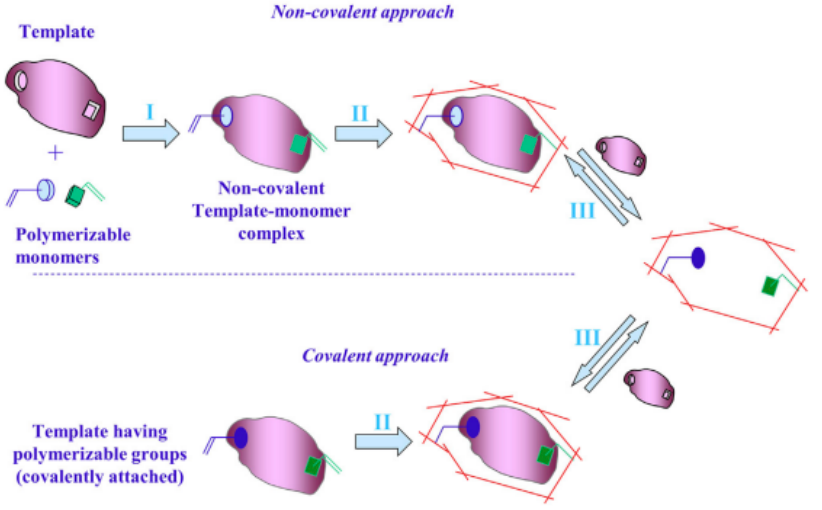
Figure 5. General method of preparation of MIPs. Adapted from [118].